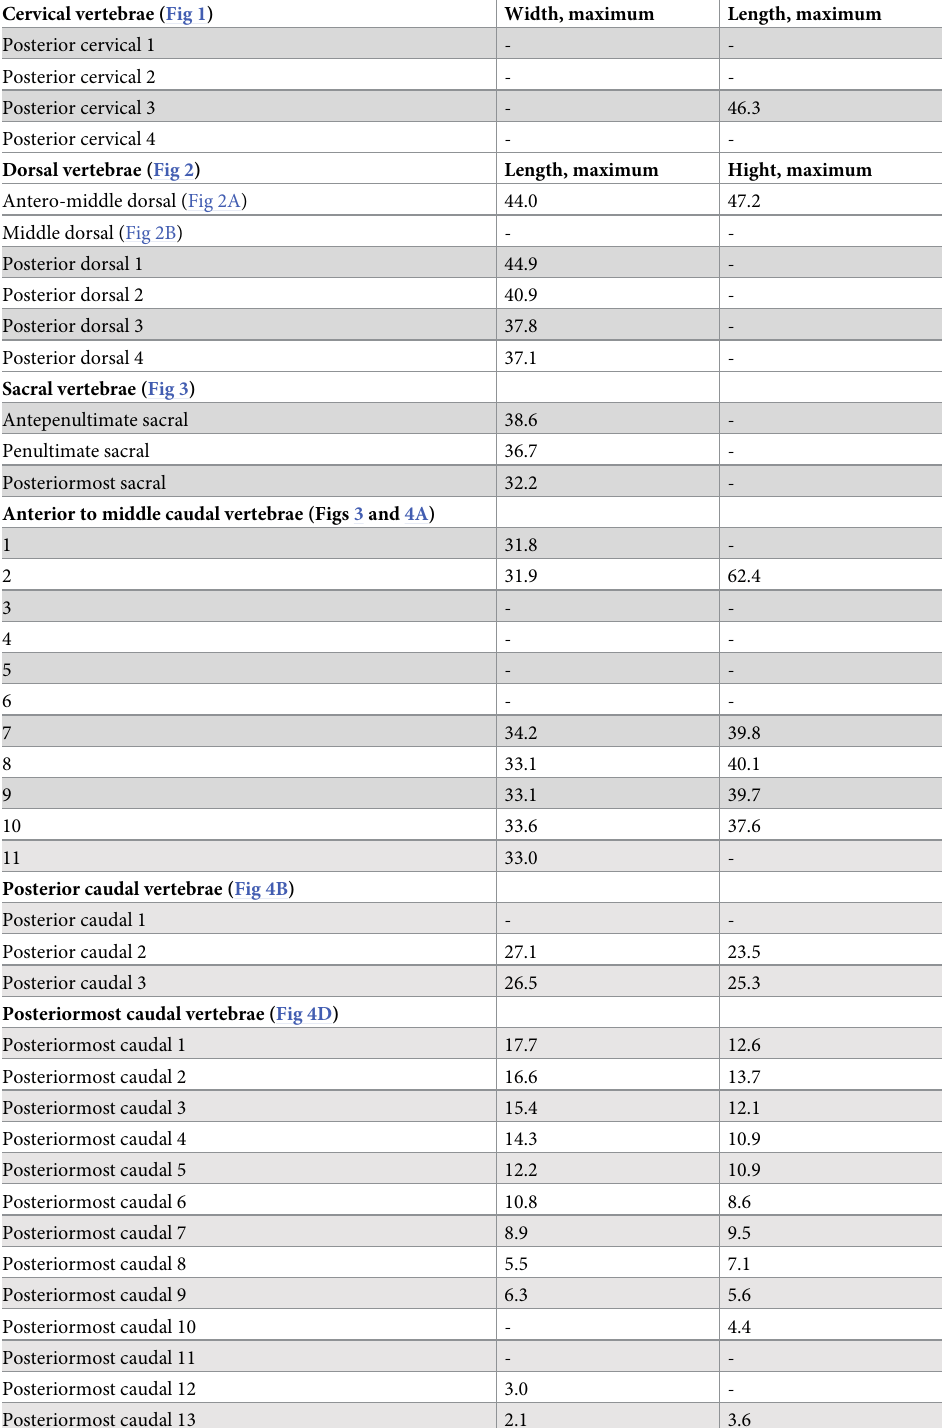
Table 1. Measurements in millimeters of vertebrae of B . inexpectus (IVPP V 11559). Cervical vertebrae (Fig 1) Width, maximum Length, maximum Posterior cervical 1 - - Posterior cervical 2 - - Posterior cervical 3 - 46.3 - - Dorsal vertebrae (Fig 2) Length, maximum Antero-middle dorsal (Fig